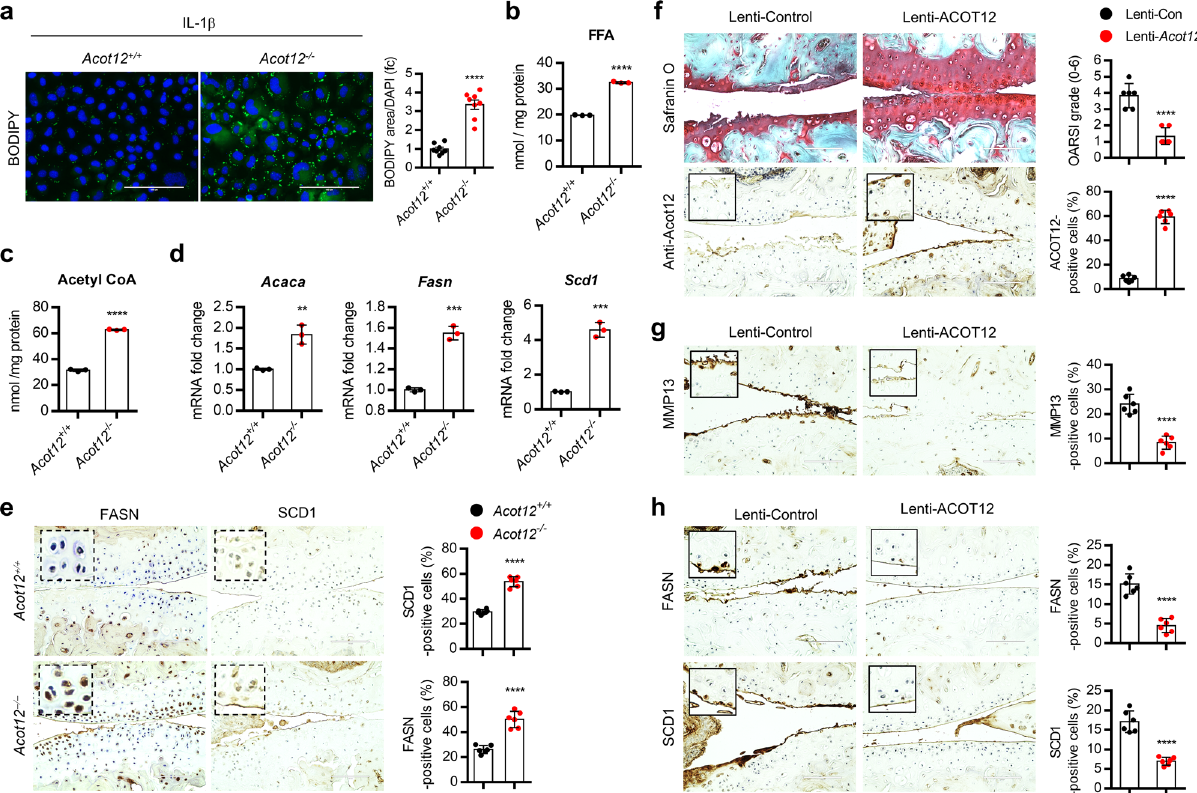
Fig. 5 Acot12 -downregulation is involved in OA pathogenesis via DNL. a BODIPY 493/503 staining and positive area in Acot12 + / + or Acot12 − / − iMACs in the presence of IL-1 β ( n = 8) P < 0.0001. Scale bar, 100 μ m. b Cellular level of FFA in Acot12 + / + or Acot12 − / − iMACs ( n = 3), P < 0.0001). c Cellular level of a c etyl-CoA in Acot12 + / + or Acot12 − / − iMACs ( n = 3), P < 0.0001. d Expression level of Acaca ( P = 0.0032), Fasn ( P = 0.0002), and Scd1 ( P = 0.0001) in Acot12 + / + or Acot12 − / − iMACs ( n = 3). e Immunohistochemistry a n d positive cell counting of FASN and SCD1 in Acot12 + / + or Acot12 − / − mice ( n = 6), P < 0.0001. Scale bar, 100 μ m. f Safranin O and ACOT12 staining in cartilage of DMM-induced OA mouse with lentiviral ACOT12 ( n = 6). The degree of cartilage degradation quanti fi ed according to OARSI grade and ACOT12 -positive cell are indicated by bar – dot plot ( P < 0.0001). Scale bar, 100 μ m. g Immunohistochemistry of MMP13 in cartilage of DMM-induced mouse with lentiviral ACOT12 ( n = 6), P < 0.0001. h Immunohistochemistry of FASN and SCD1 in cartilage of DMM-induced mouse with lentiviral ACOT12 ( n = 6), P < 0.0001. Values are means ± SD. An unpaired Student ’ s t test ( a – h ) was used for statistical analysis. ** P < 0.01, *** P < 0.001, **** P < (Supplementary Fig. 15a, b) as well as the increased number of BODIPY-, FASN-, and SCD1-positive cells were observed with the delivery of Chitosan-AcCoA into Acot12 + / + mice twice per week by intra-articular injection (Fig. 6e, f).